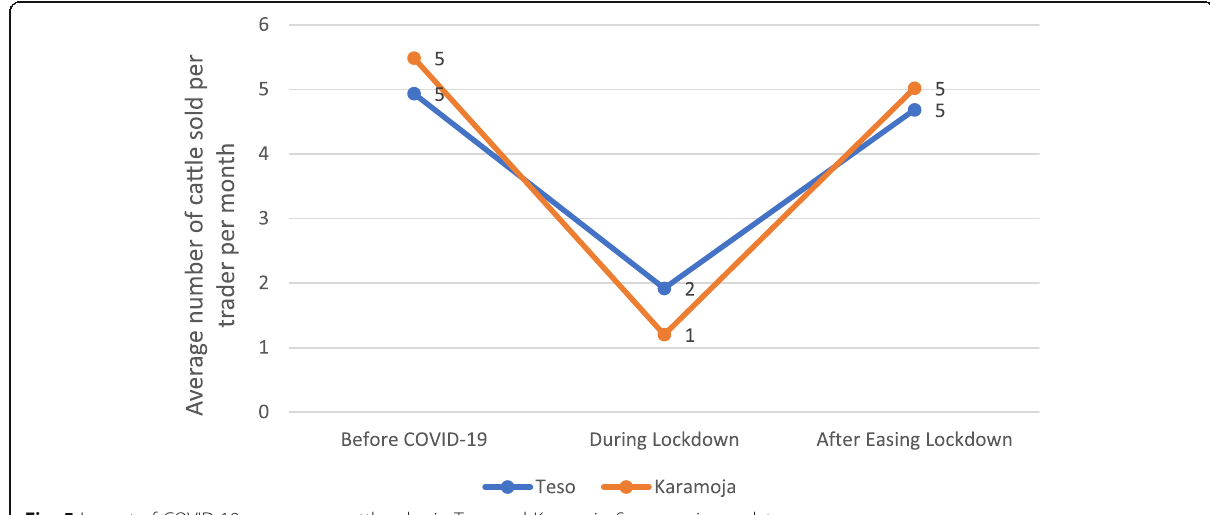
Fig. 5 Impact of COVID 19 on average cattle sales in Teso and Karamoja. Source: primary data